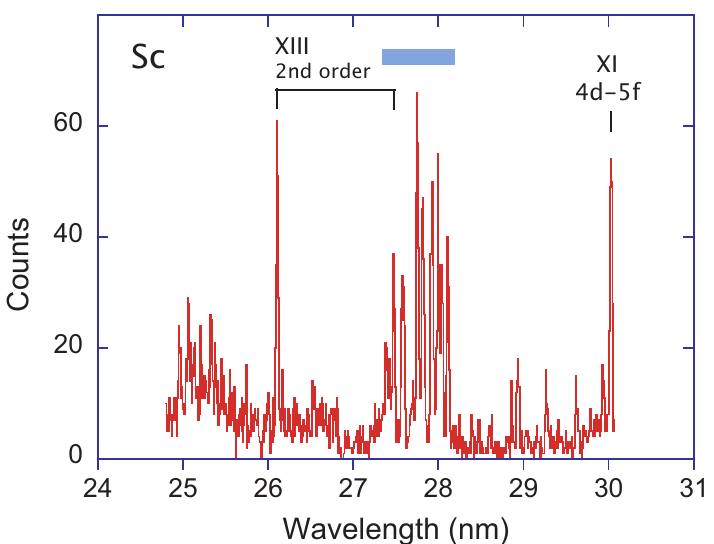
Figure 4. Beam-foil spectra of Sc at an ion beam energy of 23MeV. The strong line near 30nm may be a blend of ScXI 4d–5f transitions [7]. Observation at the foil. Line width (FWHM) 0.03nm. The lines in the wavelength interval 27.3nm to 28.1nm (blue bar) are suspect (see